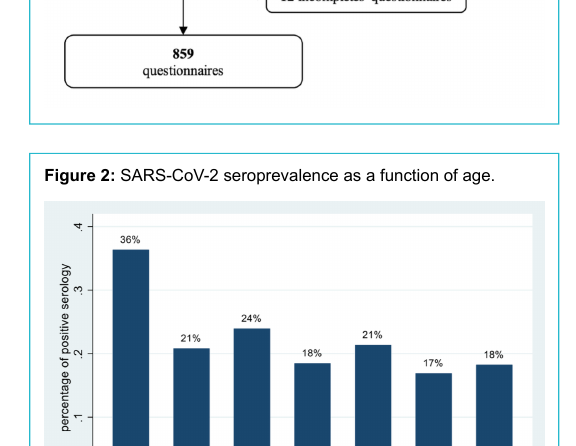
Table 1: SARS-CoV-2 seroprevalence and age groups comparison for children aged 0 to 71 months, January–March 2021 in Fribourg, Switzerland.